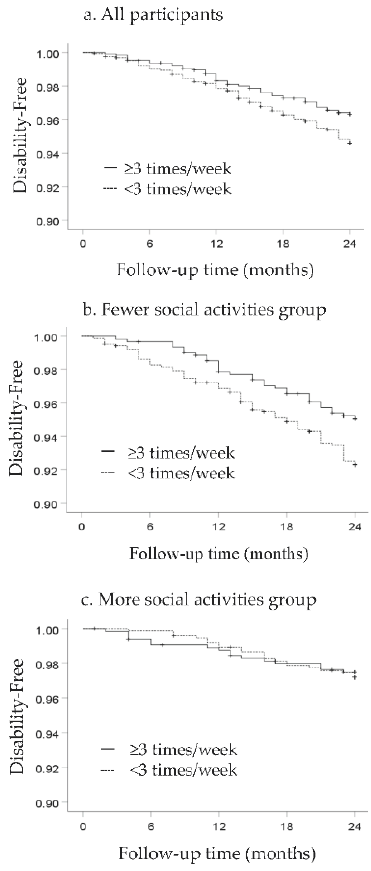
Figure 1. Kaplan–Meier survival estimates by walking habit and social activity groups. Those who walked ≥ 3 times per week had a higher probability of being disability-free than those who walked fewer than 3 times per week if their social activity was less than five activities. The relative risk reduction of disability by walking was greater among those with fewer social activities than among those with a higher number of social activities. Kaplan–Meier survival estimates by walking habit (all participants ( a ), 0–4 social activities ( b ), and 5–12 social activities ( c )). Table 3. Cox regression analysis of the relationships between walking habit and incidence of disability in each social activity group.